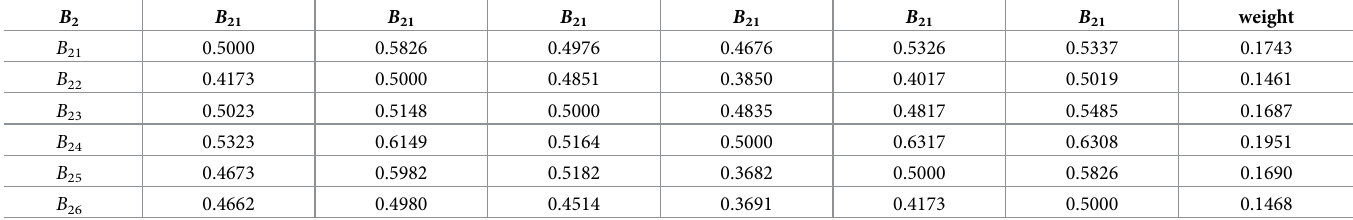
Table 12. Comprehensive judgment matrix (R_B2)